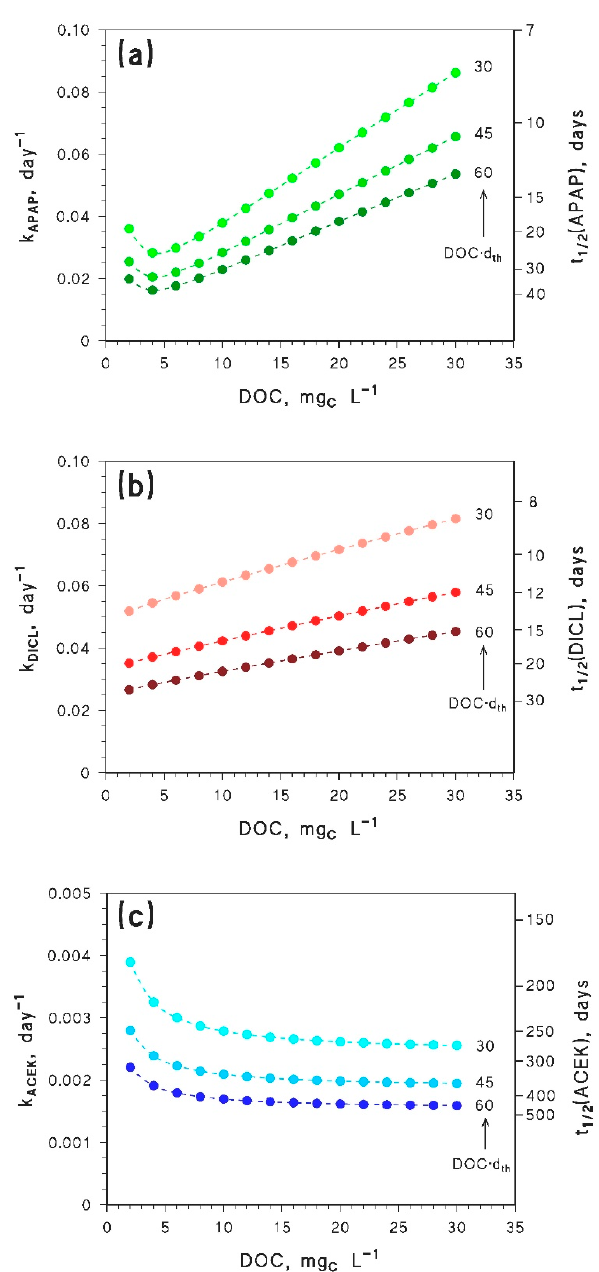
Figure 3. Modeled first-order rate constants and half-life times of ( a ) APAP, ( b ) DICL, and ( c ) ACEK in lake-water epilimnion, as a function of the DOC. The measure unit of the product DOC × d th is (m mg C L − 1 ). Other water conditions: 10 − 4 mol L − 1 NO 3 − , 10 − 6 mol L − 1 NO 2 − , 10 − 3 mol L − 1 HCO 3 − L − 1 CO 32 − . Photodegradation kinetics assumes mid-July irradiation conditions [27].